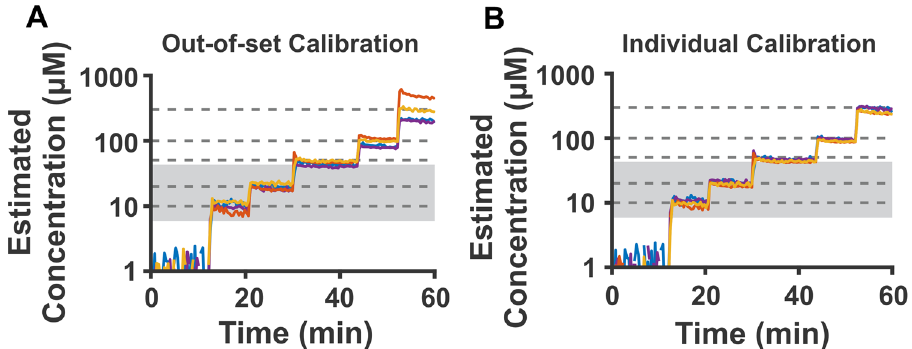
Figure 3. Calibrating sensors using out-of-set data, or calibrating individual sensors to their respective calibration curve does not greatly change sensor accuracy in vancomycin’s clinical range (highlighted in grey). ( A ) To calibrate sensors “out-of-set,” for each sensor, we calibrate using a calibration curve formed from the other three sensors. ( B ) To “individually” calibrate the sensors, we use the calibration curve collected for a specific sensor to quantify its own resulting dose–response curve.